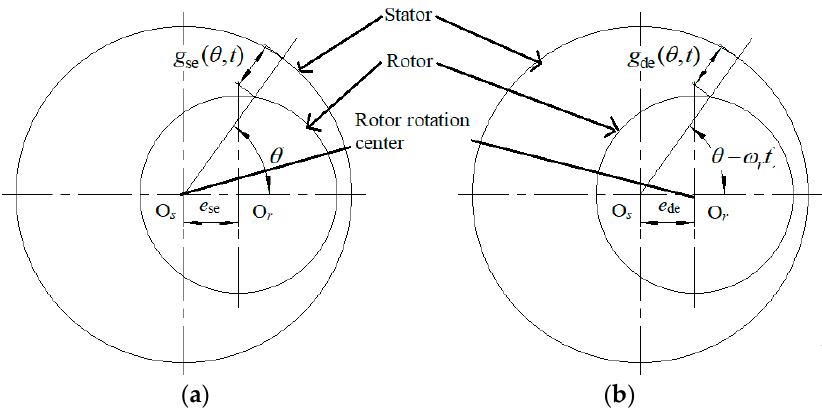
Figure 1. Schematic diagram of air-gap eccentricity: ( a ) static eccentricity; ( b ) dynamic eccentricity.